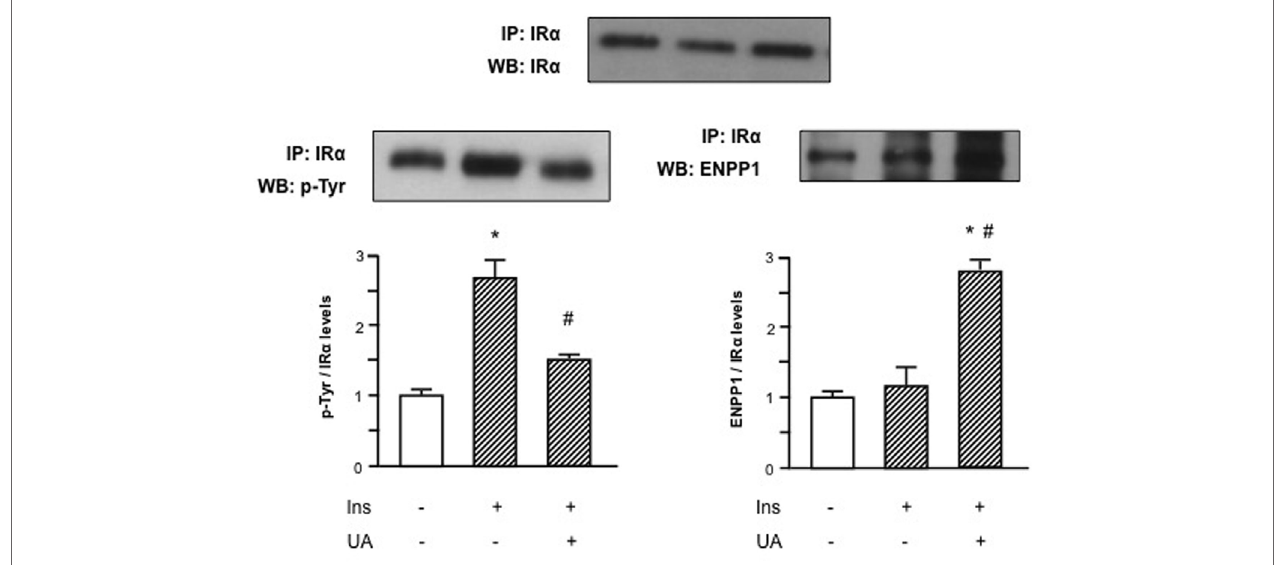
FigUre 2 | Effects of uric acid (UA) on ectonucleotide pyrophosphatase/phosphodiesterase 1 (ENPP1) binding to α -subunit of insulin receptor (I R α ) and inhibition of tyrosine phosphorylation of I R in human umbilical vein endothelial cells (HUVECs). Insulin-induced tyrosine phosphorylation of I R , as first step in the insulin signaling pathway, is prevented by the exposure of HUVECs to UA; this effect might be explained by the binding of ENPP1 to I R α induced by UA. To normalize the blots for protein levels, after being immunoblotted with anti-ENPP1 or anti-p-Tyr total antibodies, the blots were stripped and reprobed with anti-I R α total levels. Each bar represents the mean ± SD of three independent experiments and autoradiographs of a representative experiment are shown. * P < 0.05 vs basal value; # P < 0.05 vs